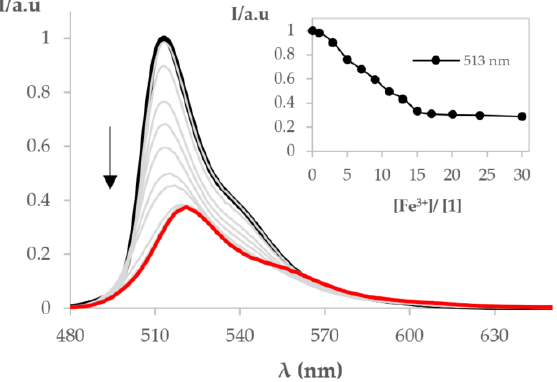
Figure 3. Spectrofluorimetric titration spectra of BODIPY derivative 1 upon the addition of increasing quantities of Fe 3+ (0 eq.—black line, to 30 eq.—red line) in acetonitrile. Inset: normalized emission intensity at 513 nm as a function of [Fe 3+ ] / [ 1 ].